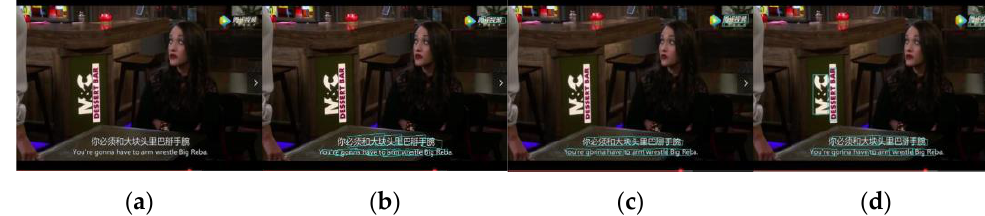
Figure 7. Comparison of the detection effect of long sequences text. ( a ) Original long text; ( b ) EAST algorithm; ( c ) Hybrid feature pyramid algorithm; ( d ) The algorithm of this paper.